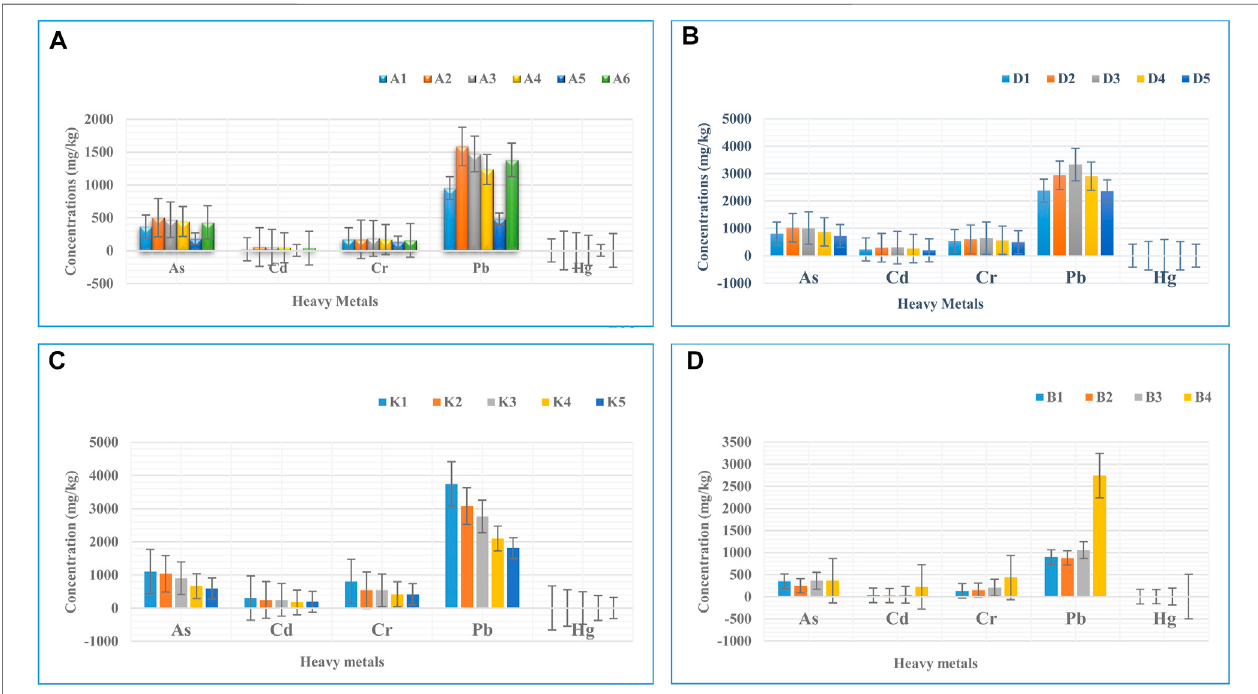
FIGURE3| Meanmetalscontentsinmg/kg(mean ± standarddeviations)insedimentssamplescollectedfromstationsinAwetu (A) ,Dololo (B) ,Kitto (C) andBoye (D) streams in Awetu watershed.